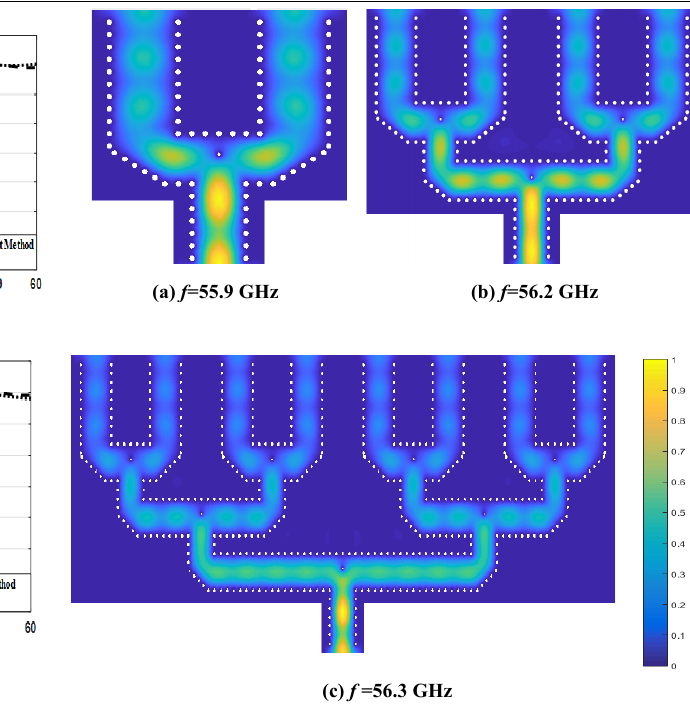
FIGURE 10. Electric-fields distribution within the SIW power dividers obtained with the quick finite element method. The fields are simulated respectively of the SIW power divider: (a) The Two-way ports, (b) the 1x4 ports and (c) the 1x8 ports